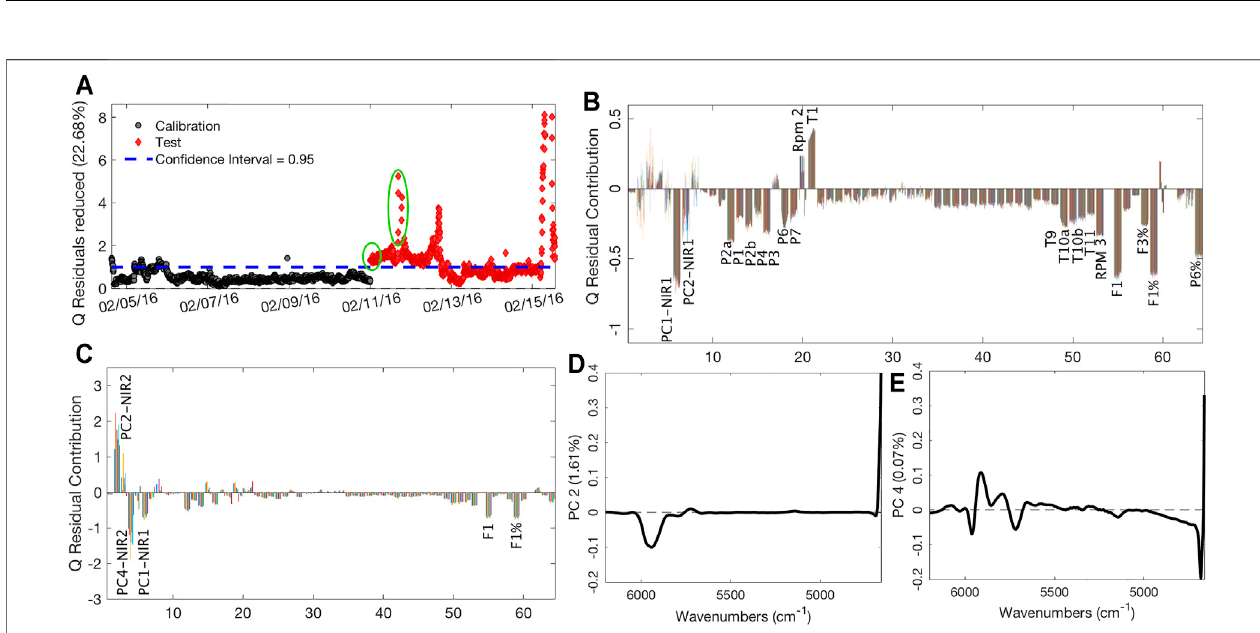
FIGURE6| Q-basedMSPCchart (A) ;contributionplotofthe fi rstgroupofcircledsamplesof PanelA(B) ;contributionplotofthesecondgroupofcircledsamples of Panel A (C) ; loadings plots on PC2 (D) and PC4 (E) of PCA performed on NIR2 dataset.